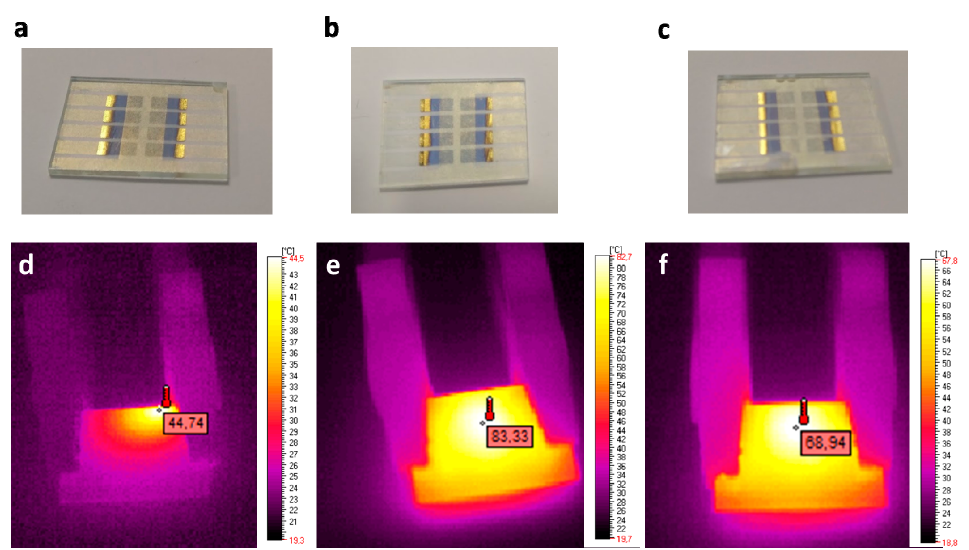
Figure 10. Images of the prepared devices: glass/ITO/TiO 2 /AZJ1/Au ( a ); glass/ITO/TiO 2 /AZJ1:TiO 2 (rutile)/Au ( b ); glass/ITO/TiO 2 /AZJ1:TiO 2 (anatase)/Au ( c ) and IR images of those devices respectively containing only AZJ1 ( d ), and mixture of AZJ1 with TiO 2 in the form of rutile ( e ) and anatase ( f ) at an applied potential of 8.5 V.